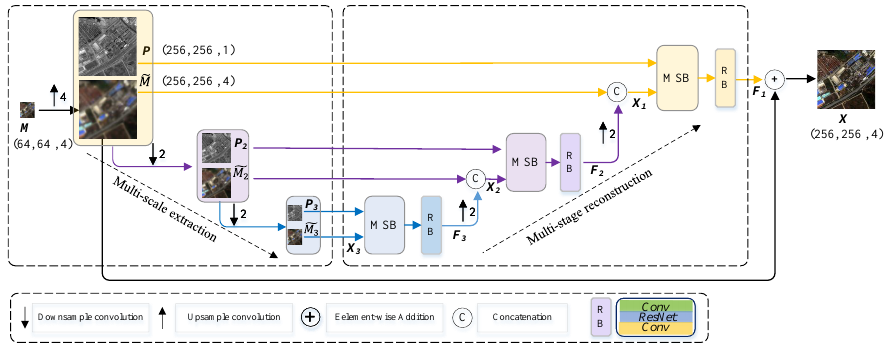
Figure 1. The framework of the multi-scale and multi-stream fusion network